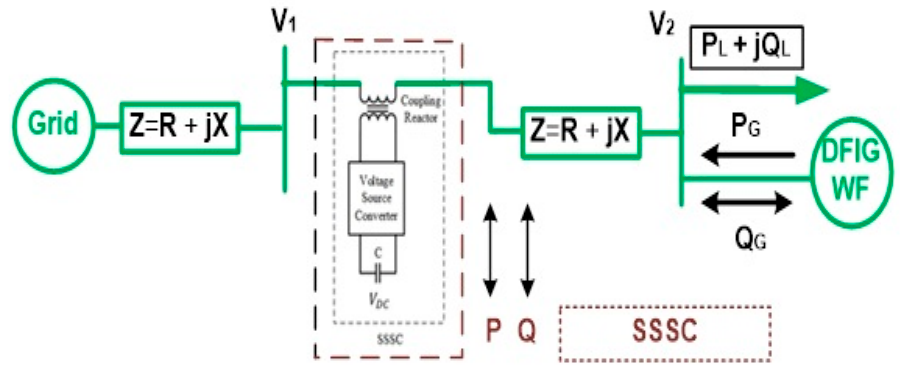
Figure A3. Schematic / connection diagram of SSSC in test system.